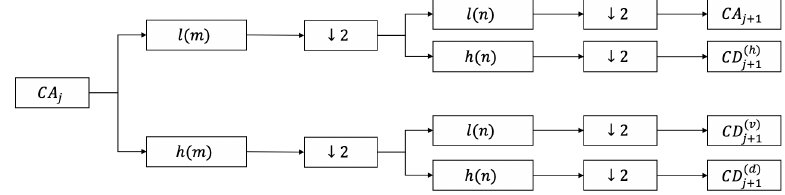
Figure 1. The procedure of 1-level 2D-DWT